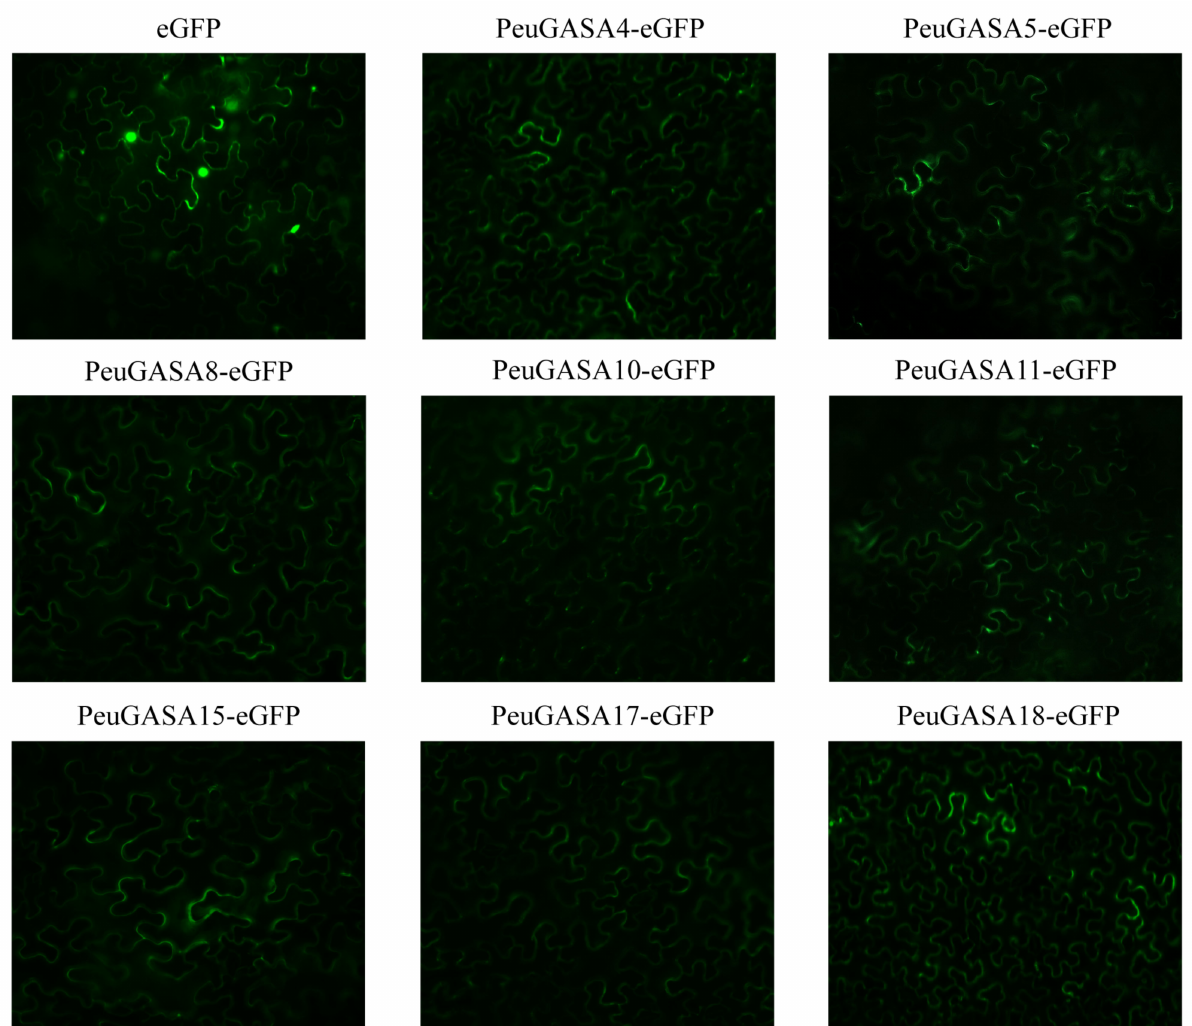
Figure 5. Subcellular localization of PeuGASA proteins. The Super::GFP and Super::PeuGASA-GFP fusion proteins were transiently expressed in